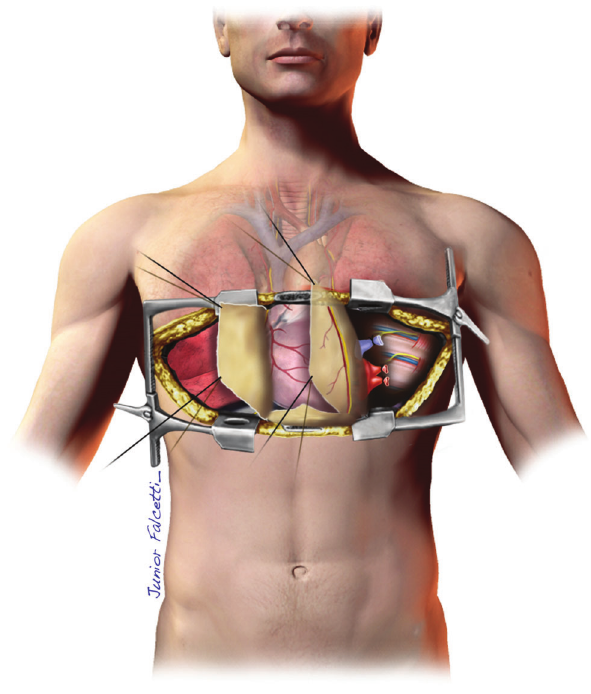
Figure 2 - The same view with retraction of the pericardium. The upper and lower pulmonary veins are now visible.